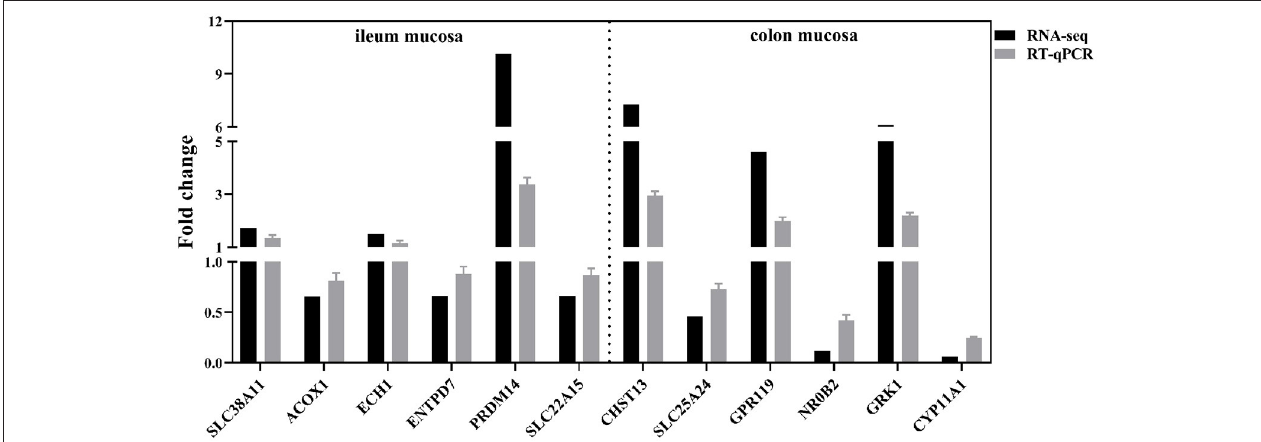
FIGURE 8 | Quantitative real-time PCR validation of the selected DEGs. SLC38A11 , solute carrier family 38 member 11; ACOX1 , acyl-CoA oxidase 1; ECH1 , enoyl-CoA hydratase 1; ENTPD7 , ectonucleoside triphosphate diphosphohydrolase 7; PRDM14 , PR/SET domain 14; SLC22A15 , solute carrier family 22 member 15; CHST13 , carbohydrate sulfotransferase 13; SLC25A24 , solute carrier family 25 member 24; GPR119 , G protein-coupled receptor 119; NR0B2 , nuclear receptor subfamily 0 group B member 2; GRK1 , G protein-coupled receptor kinase 1; CYP11A1 , cytochrome P450 family 11 subfamily A member 1. The relative quantification of the DEGs was calculated with the formula 2 − 11 Ct and normalized to β -actin control ( n = 8 per